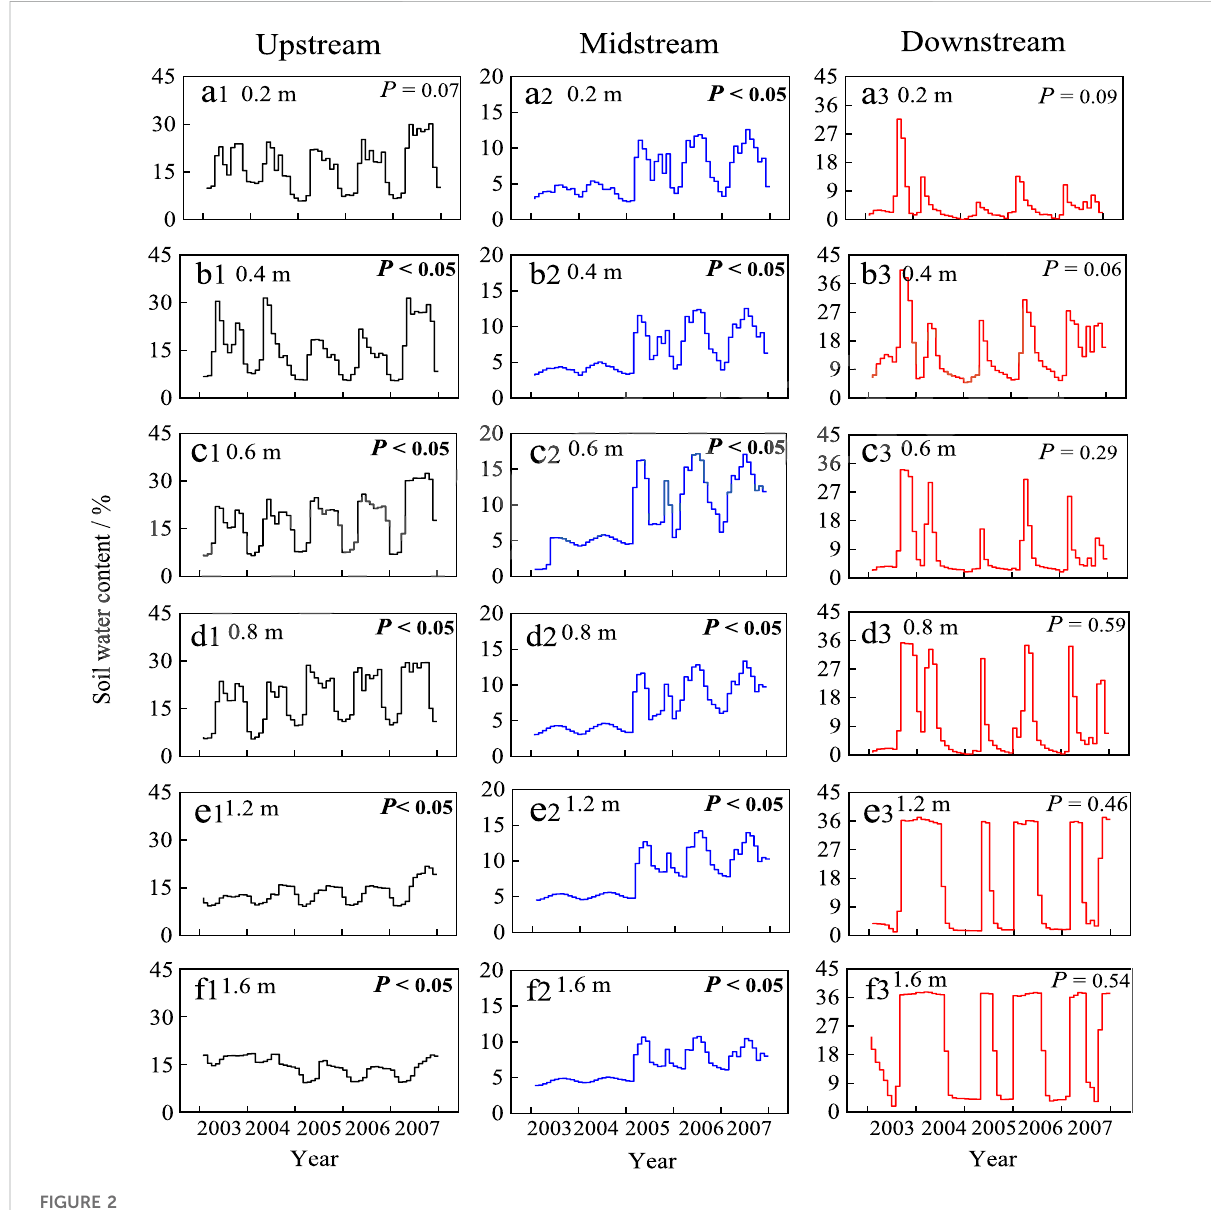
FIGURE 2 Soil moisture content at various soil depths (monthly mean). Note: a, b, c, d, e, and f indicate 0 – 20, 20 – 40, 40 – 60, 60 – 80, 80 – 120, and 120 – 160 cm,